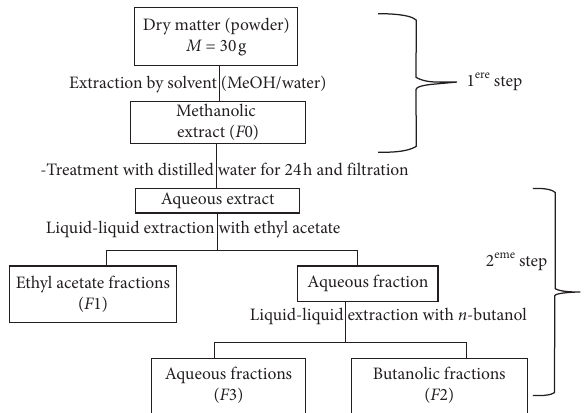
Figure 1: The fractionation step adopted for splitting into four fractions ( F 0, F 1, F 2, and F 3) of the hydromethanolic extract of Salvia officinalis leaf from two regions with F 0 hydromethanolic extract and F 1, F 2, and F 3: ethyl acetate, butanolic, and aqueous fractions,